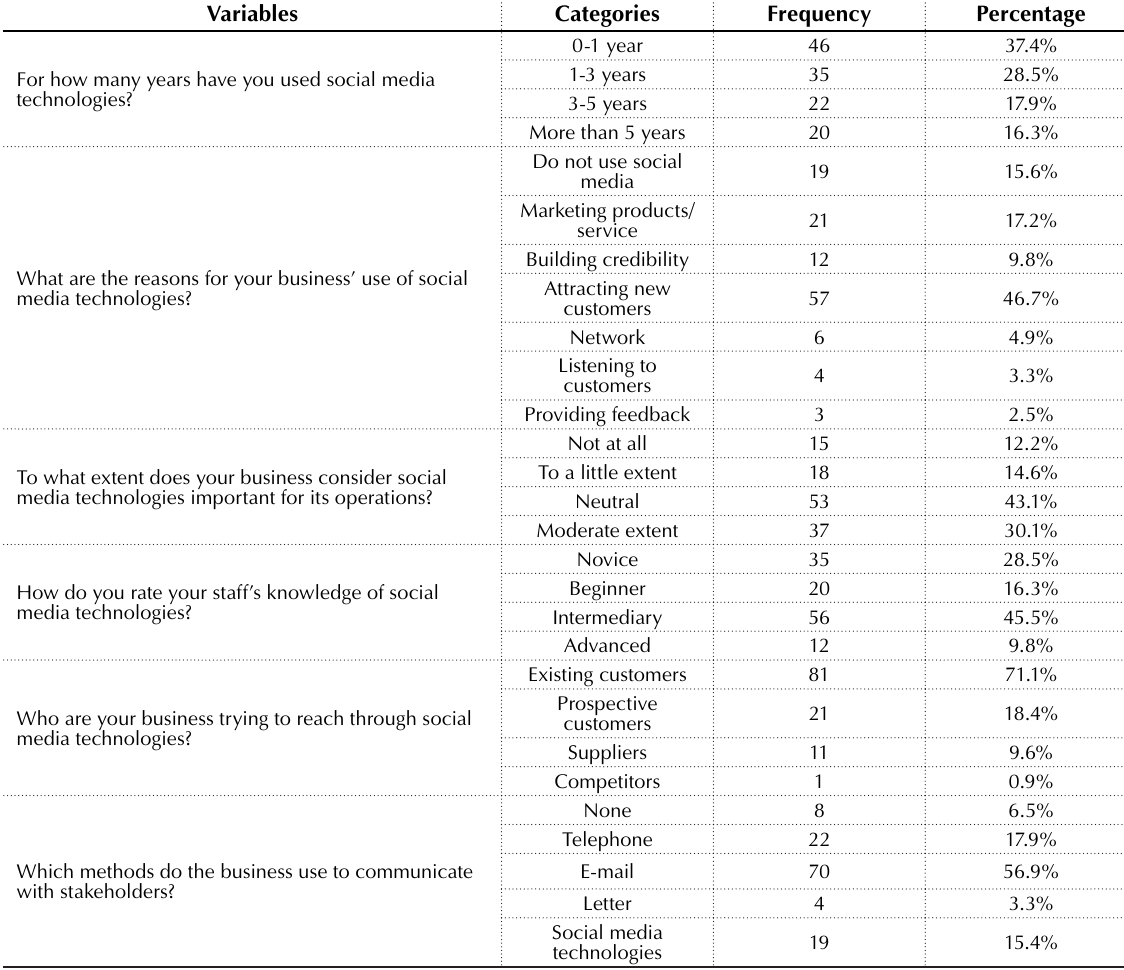
Table 4. Utilization of social media technologies